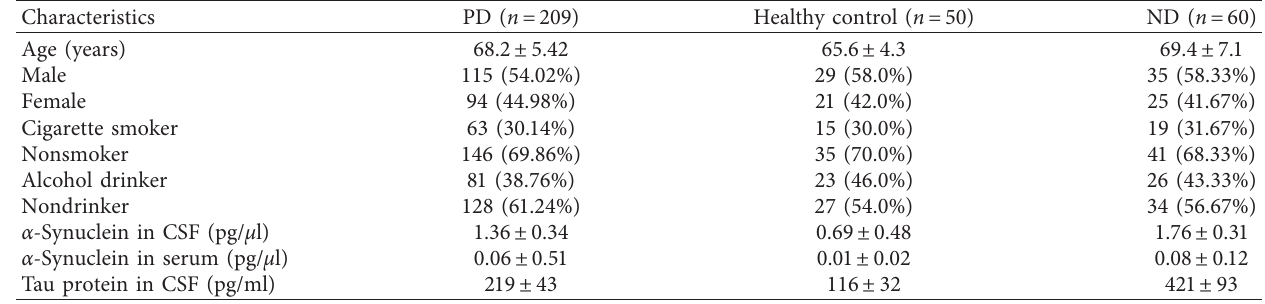
Table 1: Demographic characteristics of Parkinson’s disease (PD), neurodegenerative disorder (ND), and control subjects. Characteristics